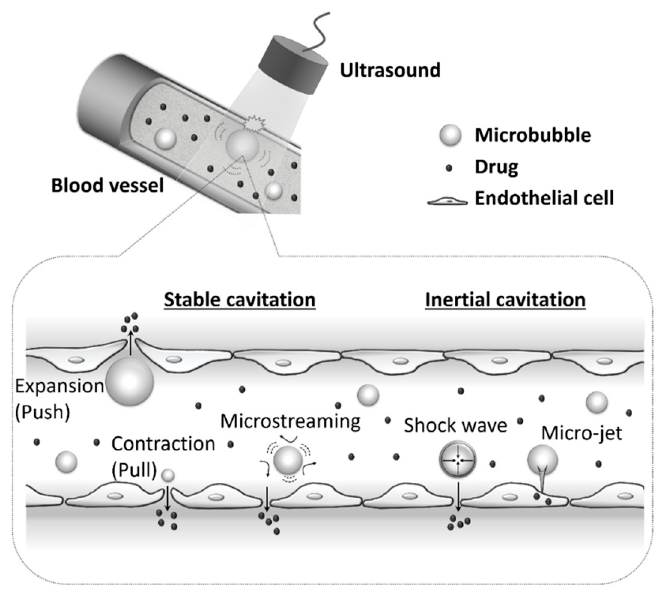
Figure 2. The e ff ects of the combination of ultrasound and microbubbles on cell membrane Figure 2. The effects of the combination of ultrasound and microbubbles on cell membrane permeability.